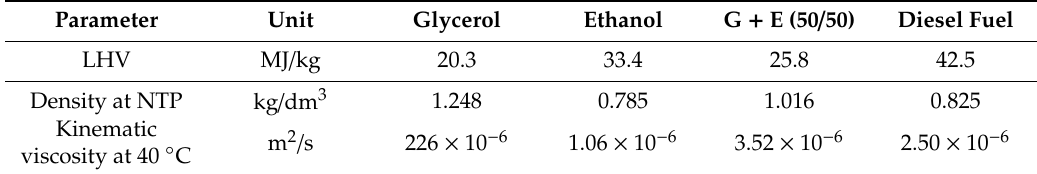
Table 3. Fuel specifications.